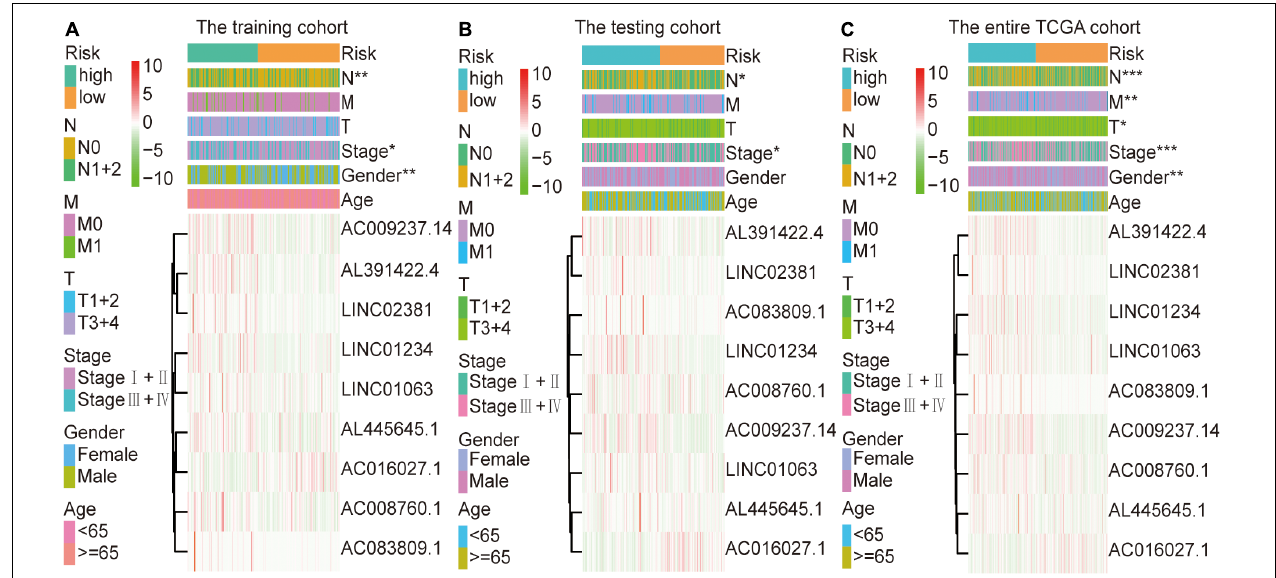
FIGURE 3 | Relationship between the risk score and clinical characteristics of colon cancer in three cohorts. (A) Risk scores were significantly associated with gender, lymph nodes, and clinical stage in the training cohort. (B) Risk scores were significantly associated with lymph nodes and clinical stage in the testing cohort. (C) Risk scores were significantly associated with gender, lymph nodes, metastases, tumor depth, and clinical stage in the entire TCGA cohort. * p < 0.05, ** p < 0.01, *** p <